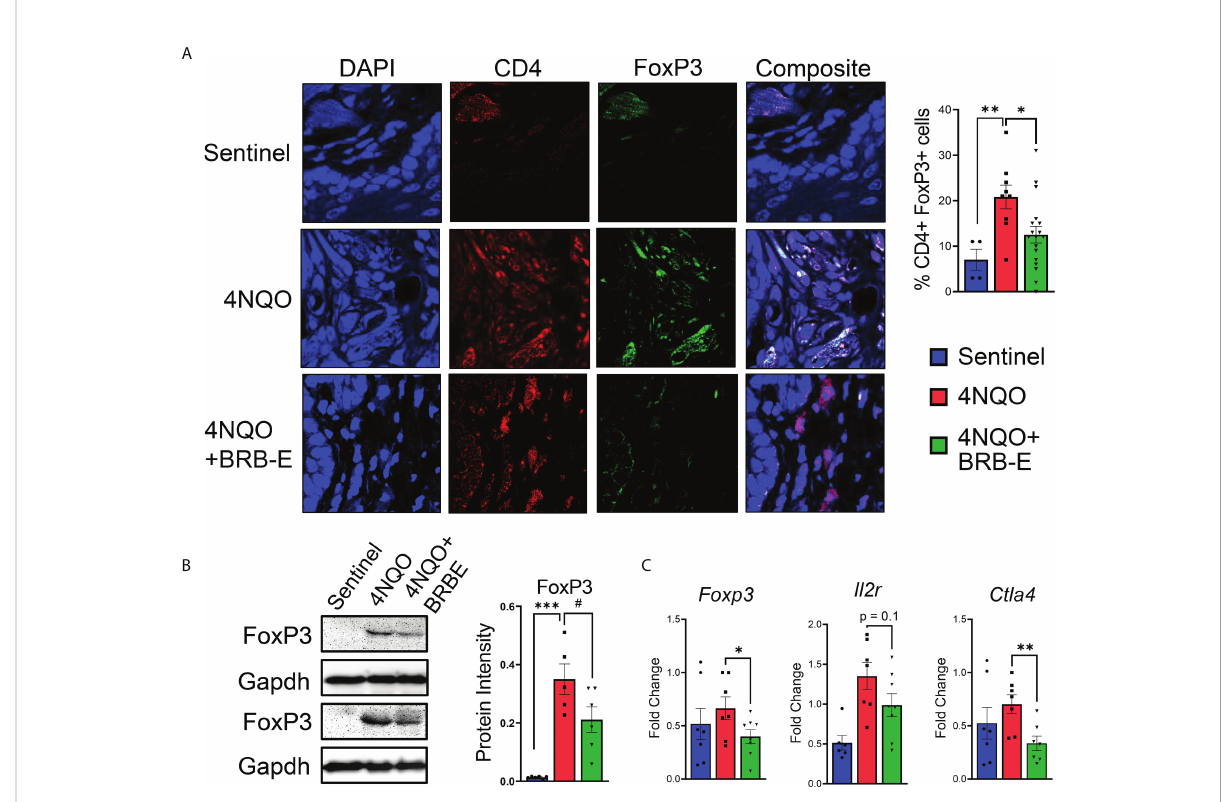
FIGURE 3 Regulatory T-cell recruitment to HNSCC tumor sites is inhibited by dietary black raspberry extract administration. (A) Multiplex confocal microscopy images of representative tongues taken from each mouse group. For each image, individual stains and composite images are shown. Each tongue was stained for DAPI (blue), CD4 (red), and FoxP3 (green). FoxP3 + CD4 + cells were quanti fi ed using ImageJ. (B) Western blot demonstrating FoxP3, and GAPDH protein content of tongue lysates isolated from sentinel, 4NQO, and 4NQO+BRB-E groups. Average protein intensity of Western blot bands was measured for several samples using ImageJ. (C) RT-qPCR data of tongue homogenate taken from sentinel or cancer-bearing mice receiving the control diet or the black raspberry extract supplemented feed for Foxp3, Il2r , and Ctla4 . Data are represented as fold change relative to the Bactin control. * p -value < 0.05; ** p -value < 0.01; *** p -value < 0.001; # p -value < 0.1 for comparisons of BRB-E treatment groups to the 4NQO-exposed control diet group using Student ’ s t